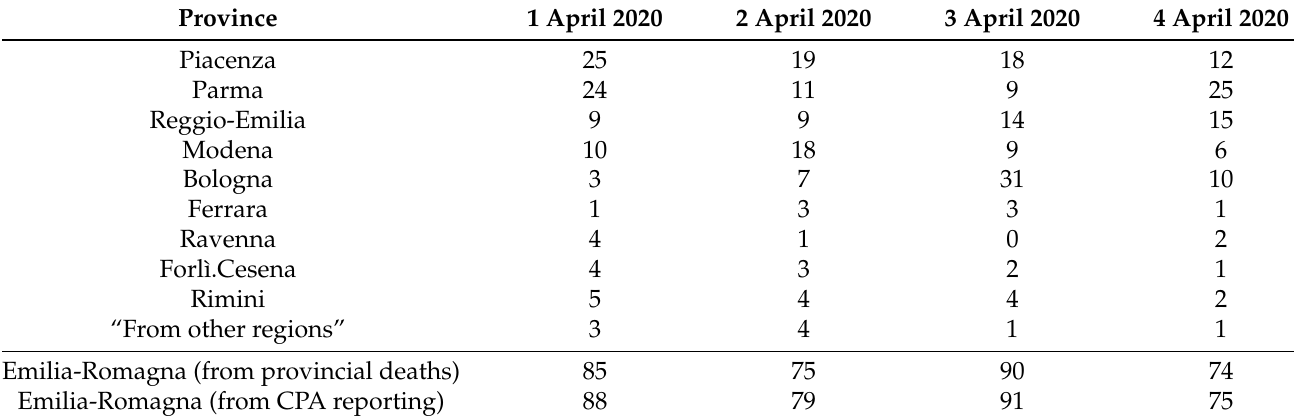
Table 3. Differences between CPA death counts and regional bulletins and local newspapers death